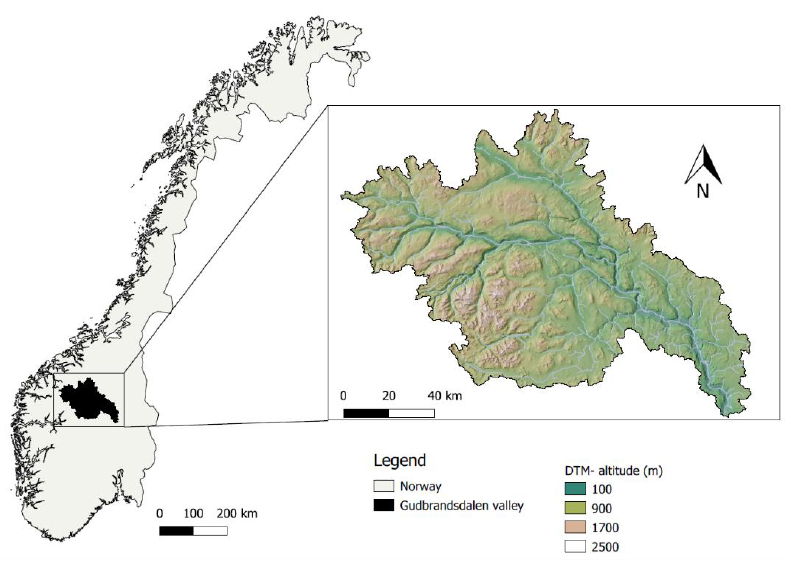
Figure 1. Location of the Gudbrandsdalen catchment in Norway and topography of the catchment.